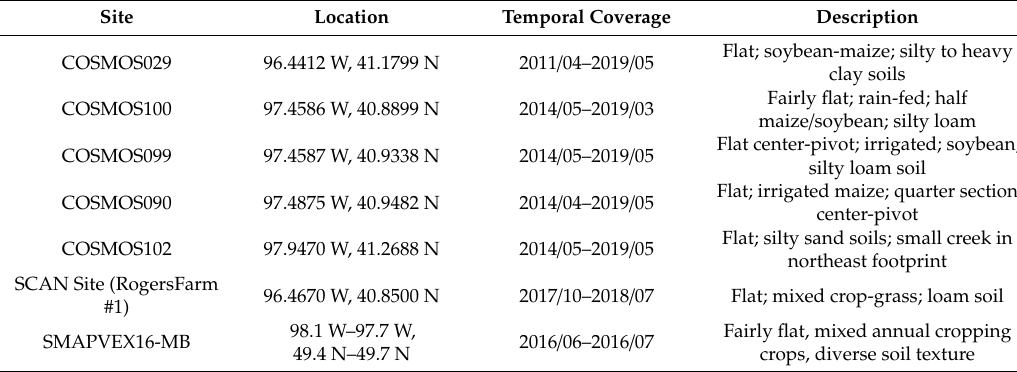
Table 1. Details of the cosmic-ray soil moisture observing system (COSMOS) and Rogers Farm #1 sites over Nebraska that provide ground soil moisture measurements for evaluating the retrieval algorithm, together with the SMAPVEX16-MB data set for developing relations between vegetation water content (VWC) and normalized di ff erence vegetation index (NDVI) / normalized di ff erence water index